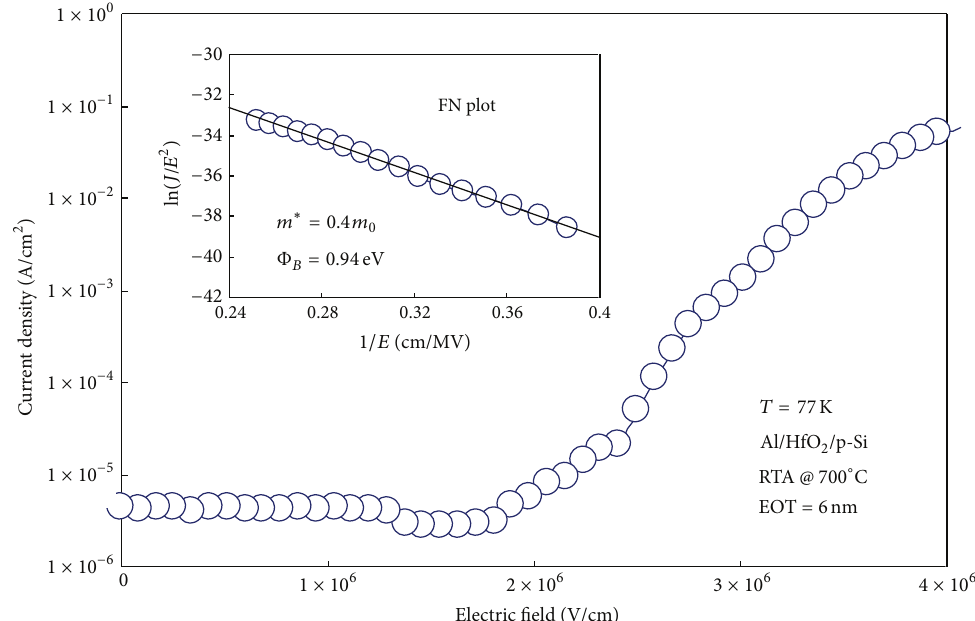
Figure 6: Characteristics of 𝐽 - 𝐸 plots for HfO 2 MIS capacitor at 77K. The inset graph presents the Fowler-Nordheim tunneling.